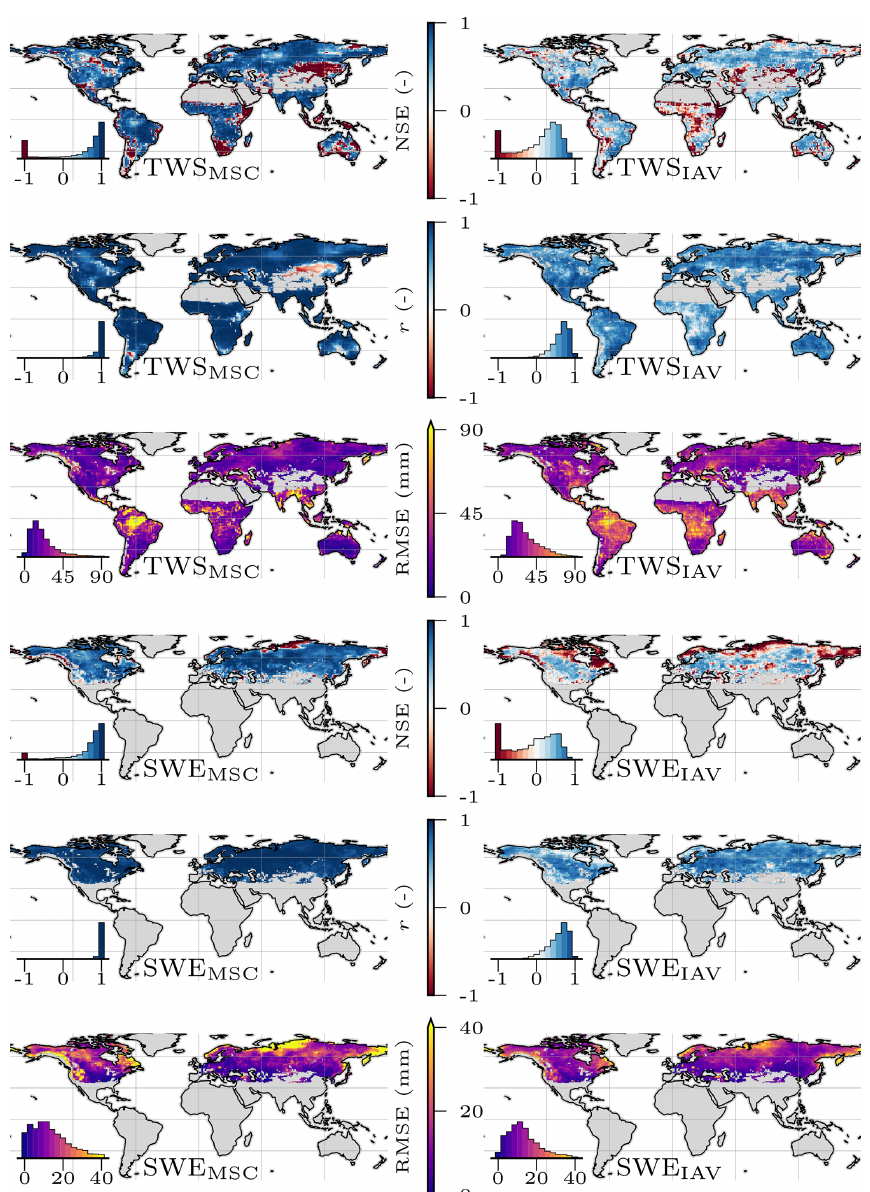
Figure A1. Local model performance for terrestrial water storage (TWS) and snow water equivalent (SWE) on the mean seasonal cycle (MSC) and the interannual variability (IAV) within the test period (2009 to 2014). The Nash–Sutcliffe model efficiency (NSE), Pearson correlation ( r ), and root mean square error (RMSE) are shown. The inset plots show the cell-area-weighted histogram of the map values.